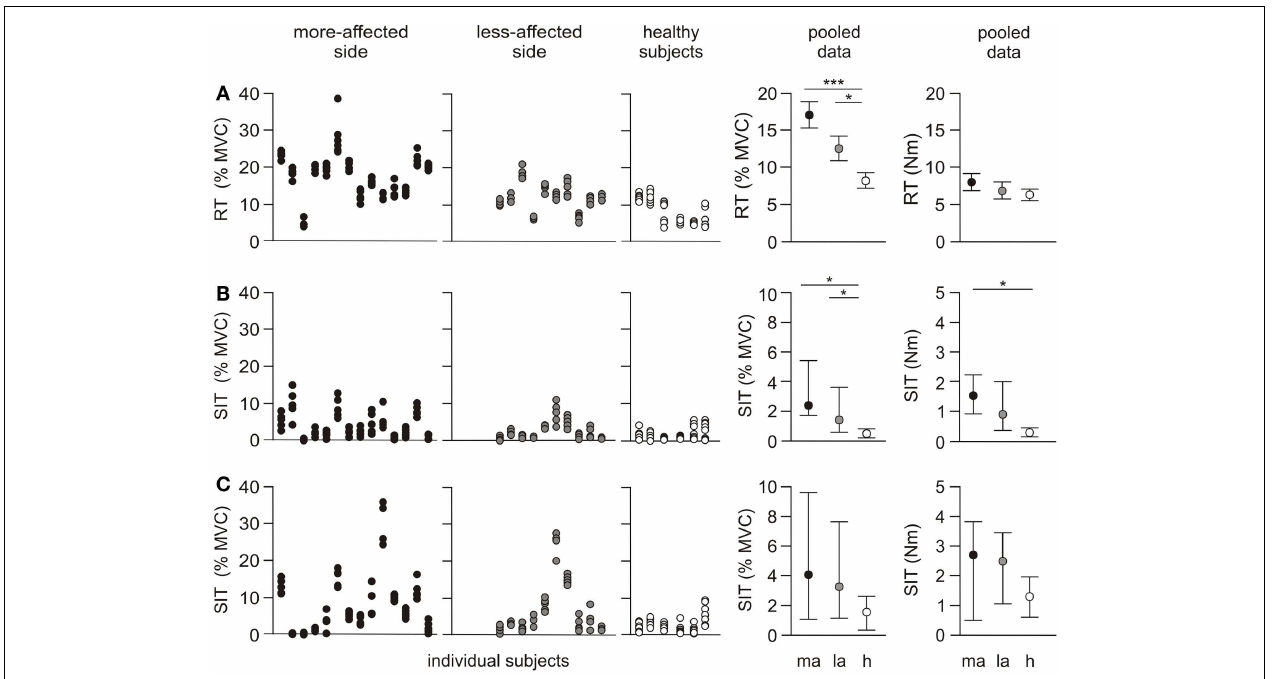
MVC) are presented as mean ± SEM. Resting twitch (Newton meter) and both rows of superimposed twitch data are presented as median and interquartile range. (A) Resting twitch (RT) evoked with peripheral nerve stimulation over biceps brachii (B) superimposed twitch (SIT) evoked with peripheral nerve stimulation over biceps brachii (C) superimposed twitch evoked with cortical stimulation. * p < 0.05, *** p <